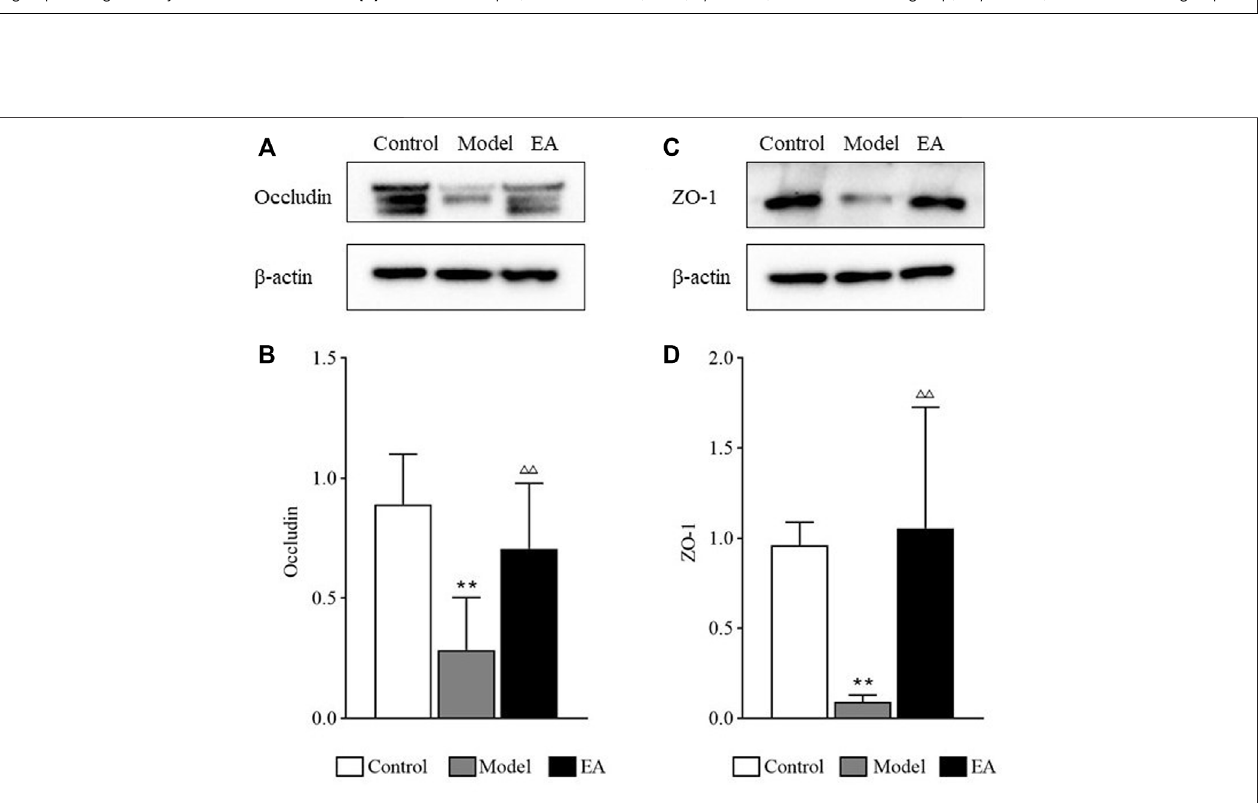
FIGURE 9 | Tight junction proteins expressions. Occludin (A) and ZO-1 (C) expressions were measured by western blot. One-way ANOVA indicated that the expressionsofoccludin (B) andZO-1 (D) weresigni fi cantlyloweraftermodelingandsigni fi cantlyhigherafterEAtreatment.Bar:mean±SE, n =10,** p < 0.01,versusthe control group; △△ p < 0.01, versus the model group.